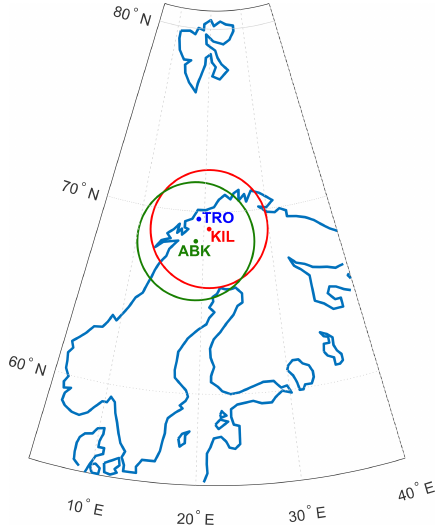
Figure 1. Geographic locations of ground-based ASC stations (KIL and ABK) from the MIRACLE network and locations of EISCAT radars (TRO). KAIRA FOV is the same as KIL